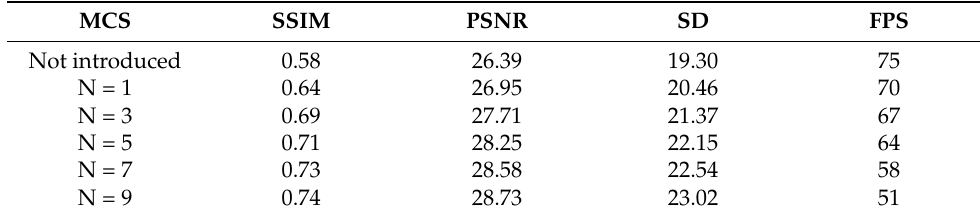
Table 7. Introducing the Monte Carlo search time comparison.